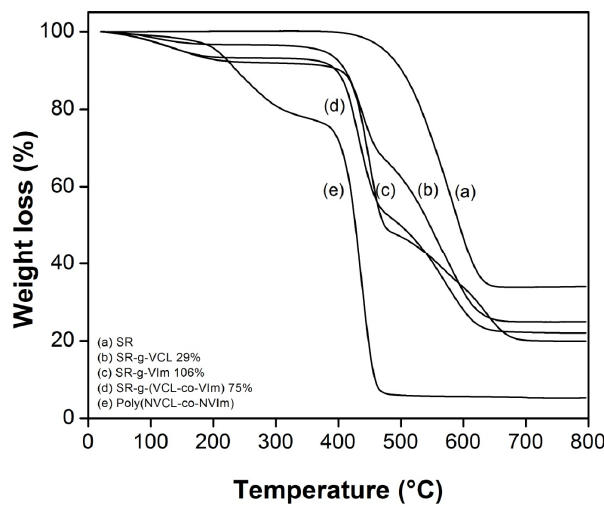
Figure 5. Thermogravimetric curves for SR alone ( a ), SR-g-VCL 29% graft ( b ), SR-g-VIM 106% graft ( c ), SR-g-(VCL-co-VIM) 75% ( d ), and poly(NVCL-co-NVIM) ( e